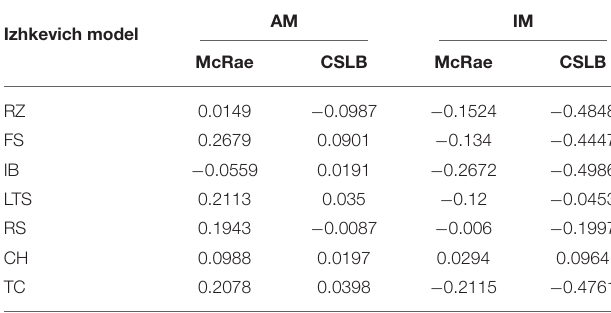
TABLE 3 | The sensibility of IM and AM results to modality